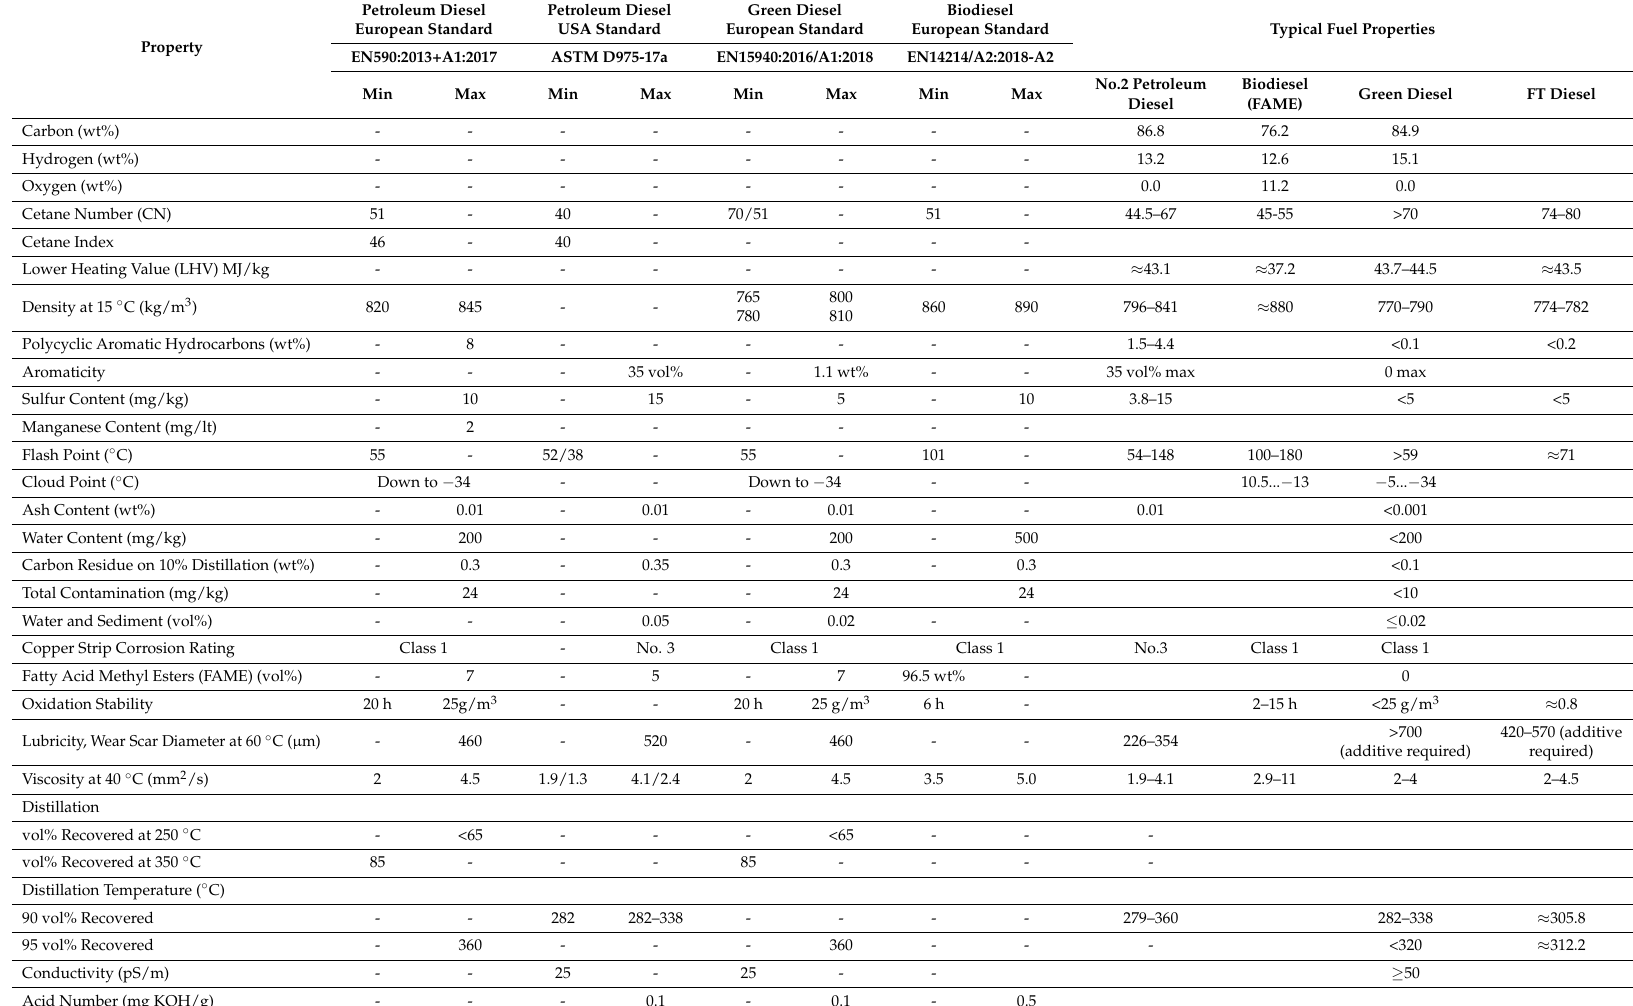
Table 9. Standards and typical properties of petroleum Diesel (No.2), biodiesel and Green Diesel. Data from